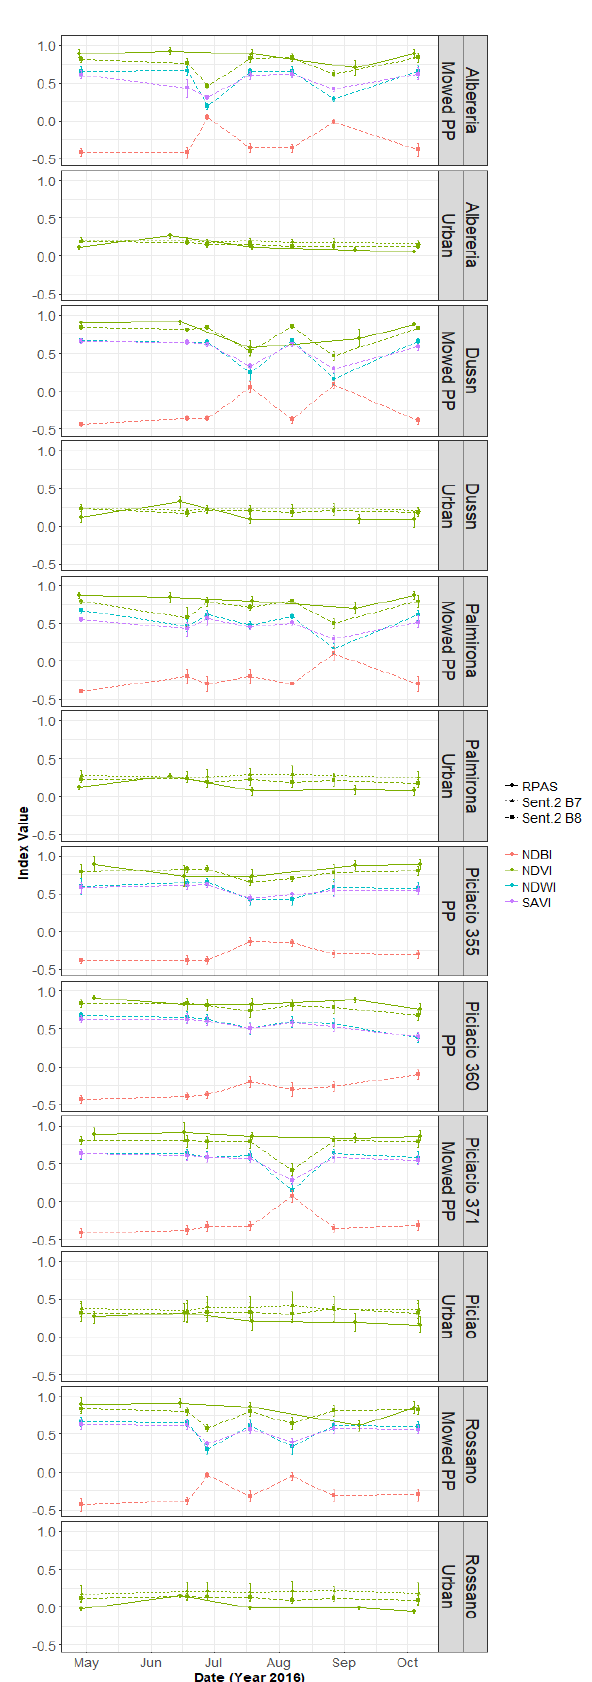
Figure 5. Mean values of indices inside areas with different classes – standard deviation is reported in error bars.